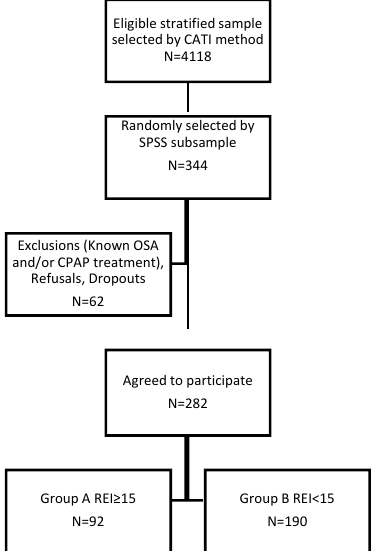
Figure 1. Study selection flow chart.